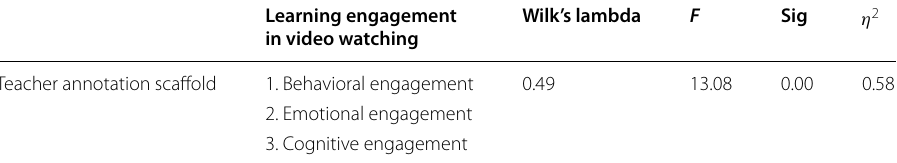
Table 2 Multivariate effects for learning engagement in video watching